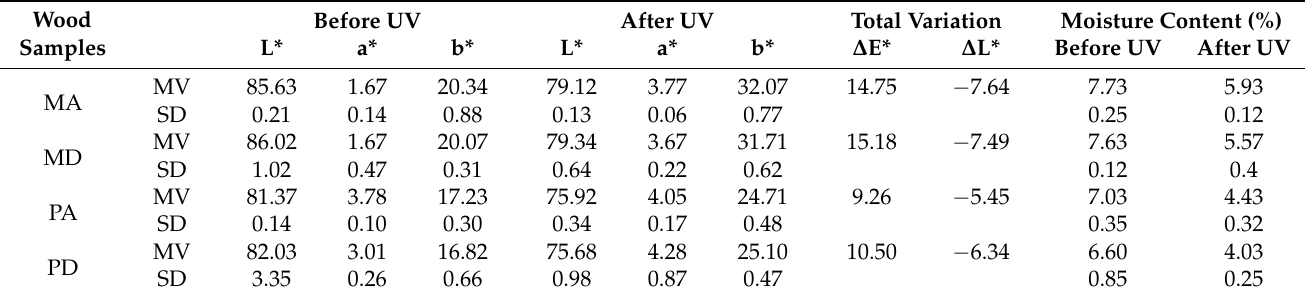
Table 1. Color co-ordinates L*, a*, and b*, measured before and after exposure to